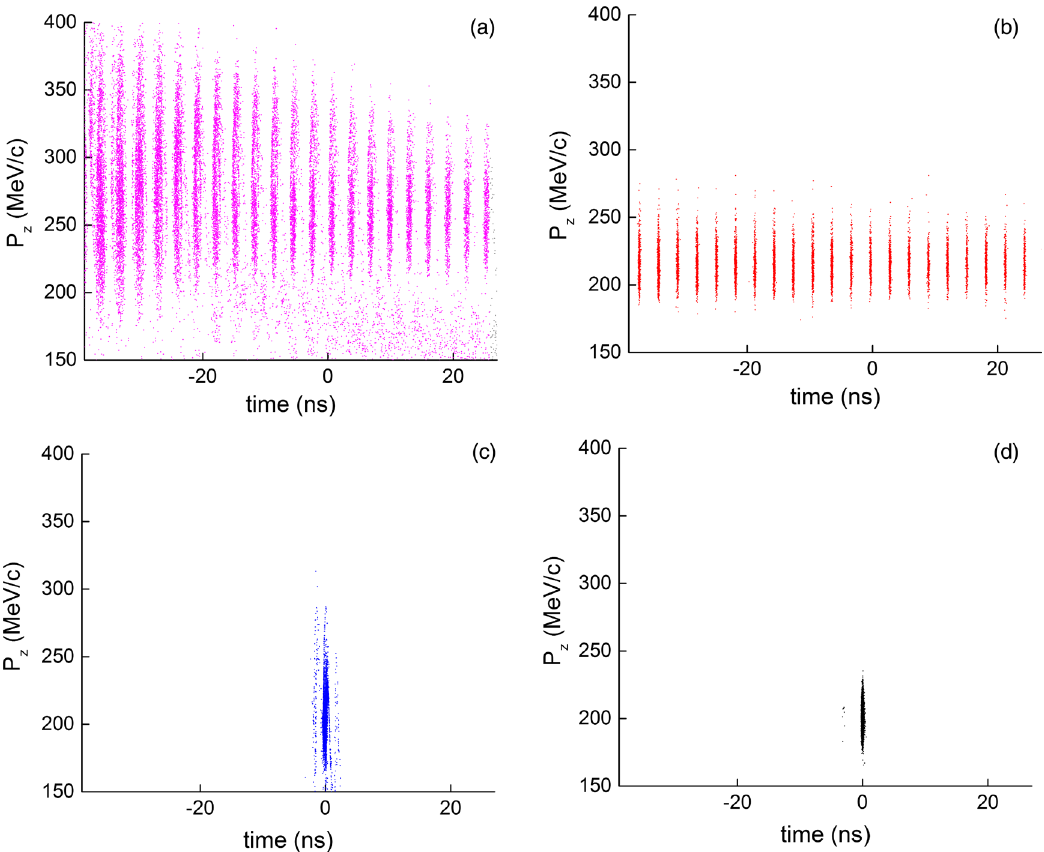
FIG. 8. Snapshots of a sample of the longitudinal phase space at various positions along our proposed 6D rectilinear cooling channel: (a) at the entrance of the cooling channel before recombination; (b) at the entrance of the bunch merger; (c) at the exit of the bunch merger [26]; (d) at the end of the 6D cooling